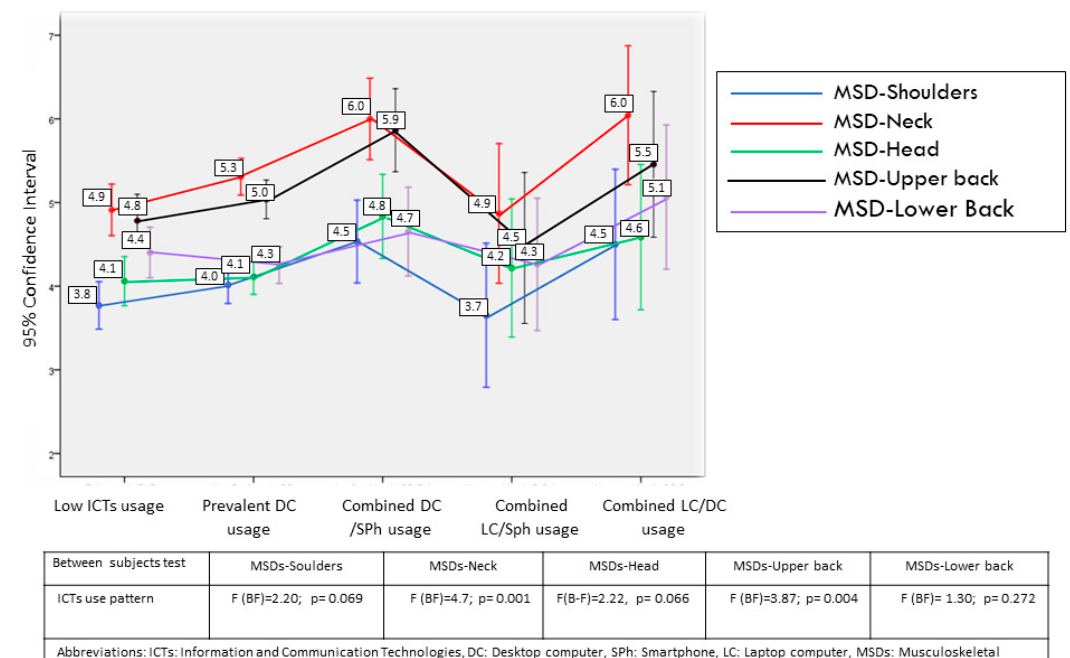
Figure 4. Relationships between MSDs and ICT usage pattern (2).